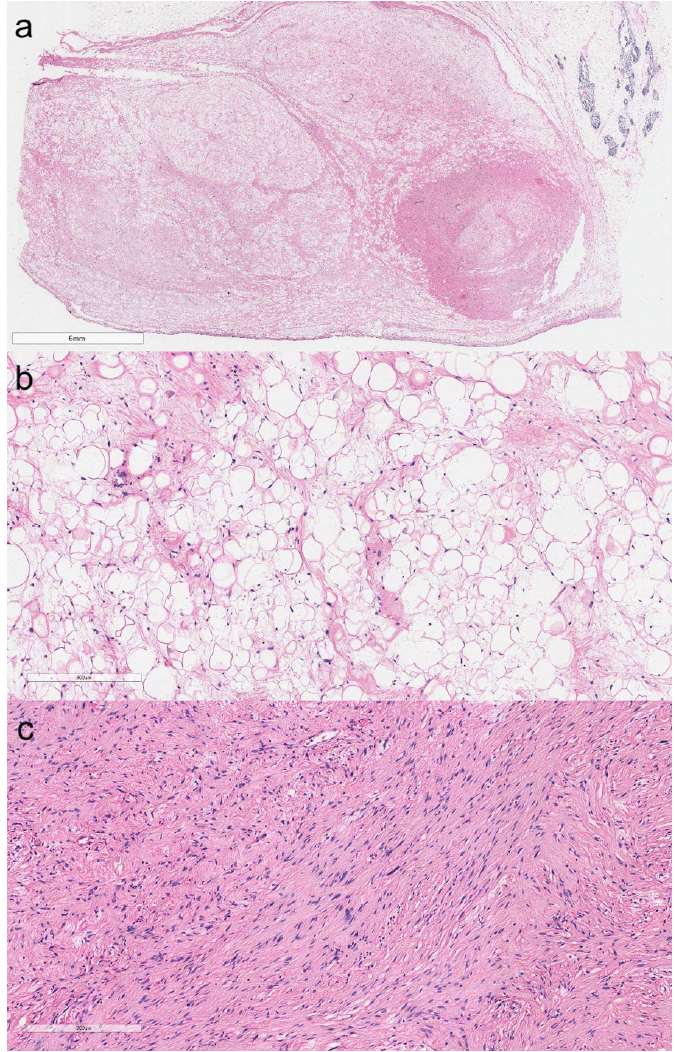
Figure 6. Dedifferentiated thymoliposarcoma. At the top right, thymic residues are visible ( a , hema- toxylin and eosin, original magnification ×10). The neoplasm was composed of a well-differentiated liposarcoma ( b , hematoxylin and eosin, original magnification ×200), showing abrupt transition to a non-lipogenic spindle cell sarcoma ( c , hematoxylin and eosin, original magnification ×200).